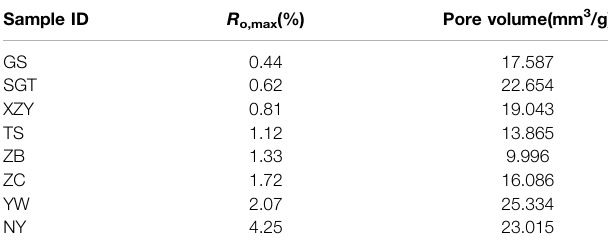
TABLE 4 | Pore volume per unit mass of each coal sample.